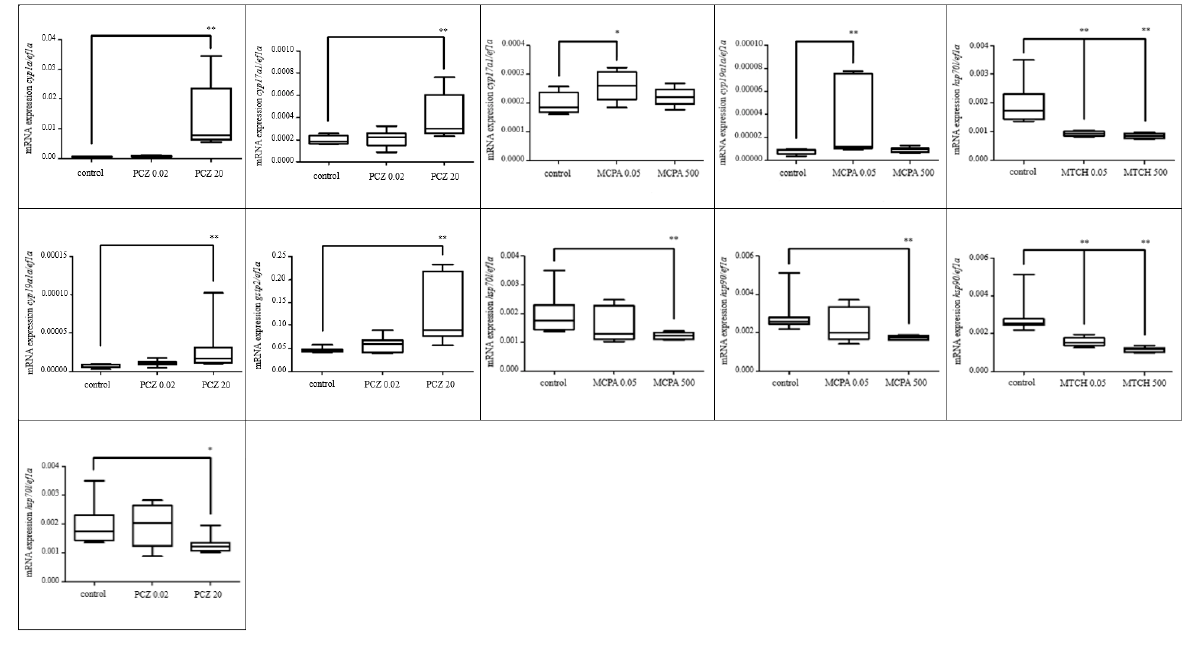
Figure 1. Relative mRNA expression of selected genes in D. rerio embryos exposed to various pesticides. Concentrations are indicated in µg/L. Box plot graphs were constructed using median, Q1, Q2 with whiskers of maximum 1.5 interquartile range. Statistically signi fi cant di ff erences are indicated by * ( p < 0.05) or ** ( p < 0.01).